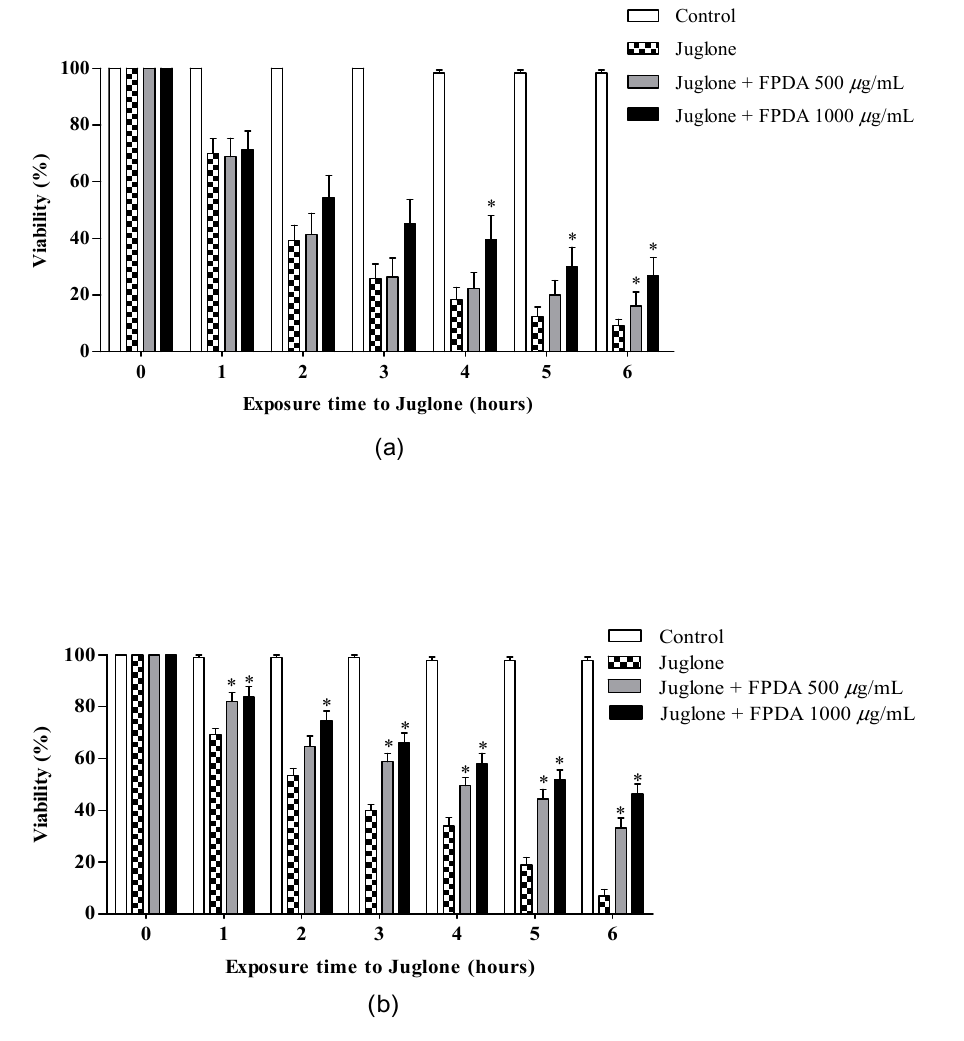
Figure 5. Oxidative stress in the in vivo experimental model C. elegans treated with FPDA from eggs until the L4 phase . ( a ) Treatment with FPDA interrupted at the time of stress induction with juglone; ( b ) Treatment with FPDA not interrupted at the time of stress induction with juglone. * Statistically significant results ( p < 0.05) when the treated group was compared with the control group. Values are expressed as the mean ±